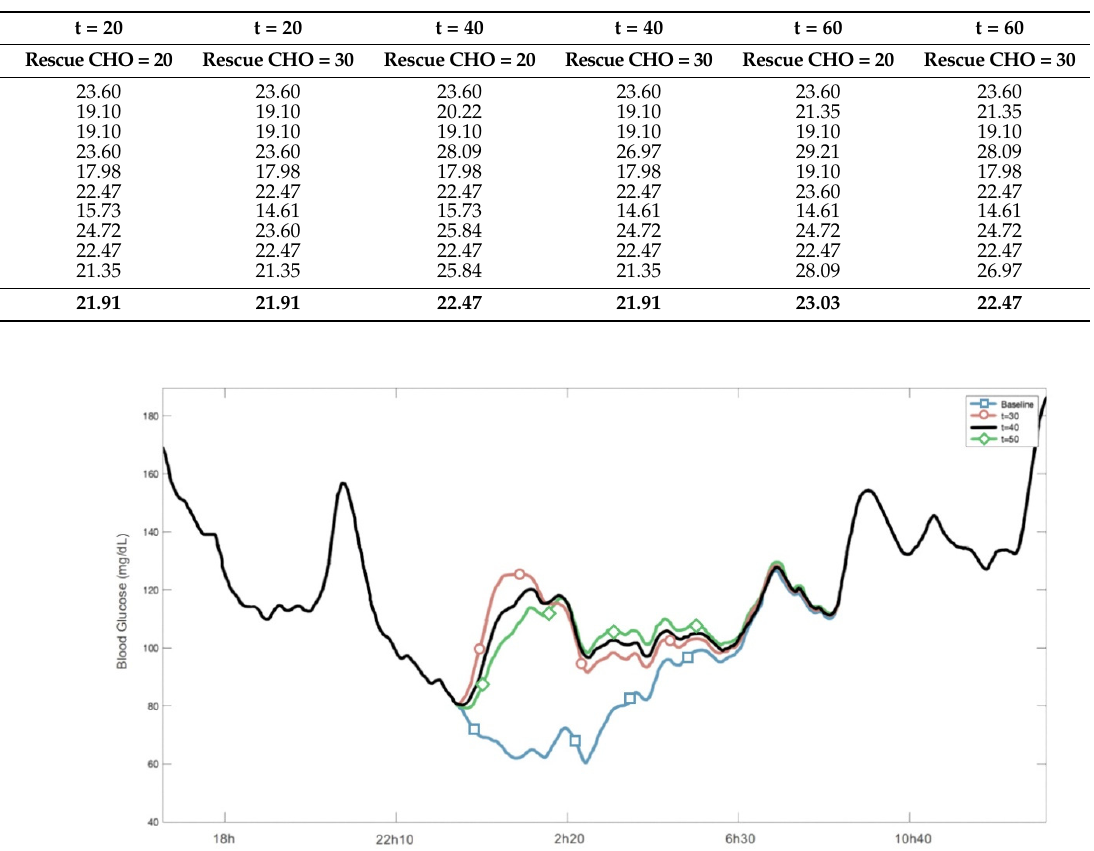
Table 4. Percentage of nights with hypoglycemia between 00:00 and 06:00. Results are expressed in percentages. The baseline simulation corresponds to the same simulation, but without rescue CHO.